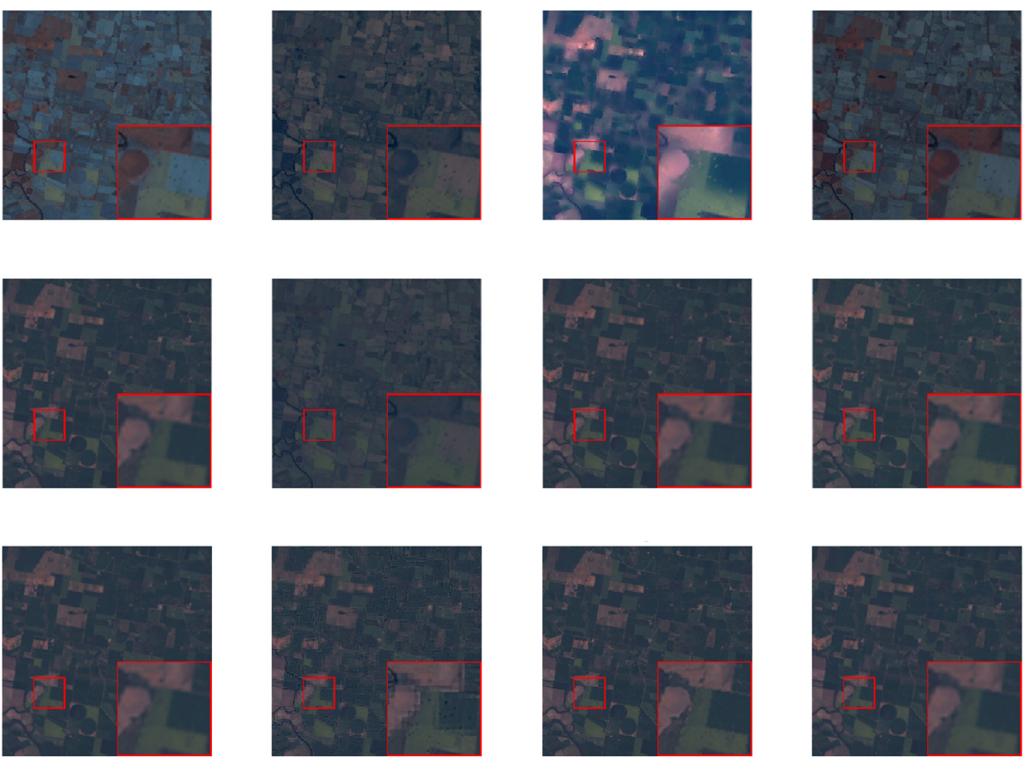
Figure 12. The fourth group of visualization results. Table 4. The fourth group of quantitative results.